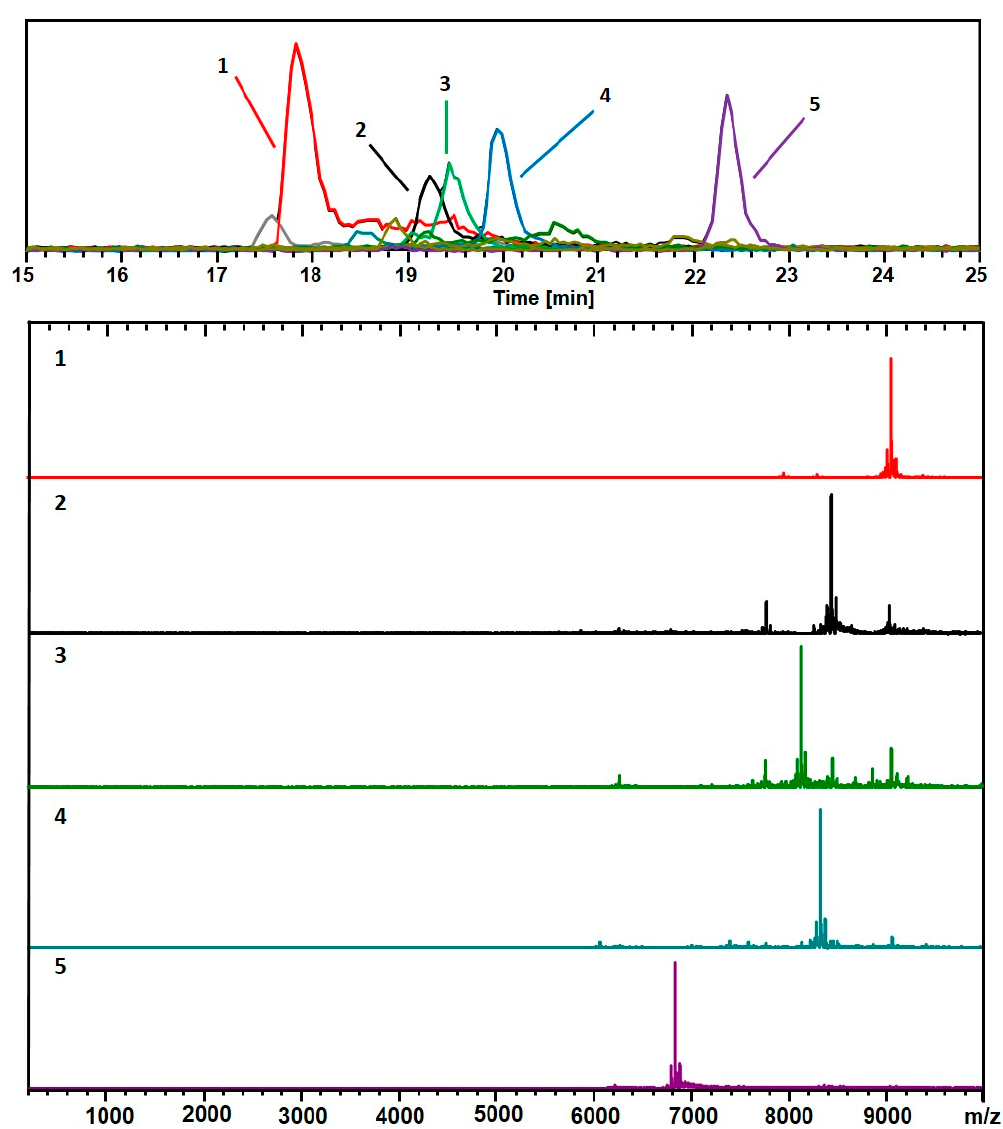
Figure 2. As in Figure 1, but with a positive (ESI + ) mode for detection. This analysis shows mainly 2+ charge-states. The black trace corresponds to the base peak chromatogram ( m / z 100–10,000). The color-coded EIC chromatographic peaks track with the coded and numbered mass spectra listed herein, with compositions assigned as follows: (1, Red) (67, 30), 18.1 kDa; (2, Black) (60, 31), 16.9 kDa; (3, Green) (58, 30), 16.2 kDa; (4, Blue) (60, 30), 16.6 kDa; and (5, Purple) (48, 26), 13.6 kDa. The fine structures of the (67, 30) 2+ complexes are presented in Figure S2.